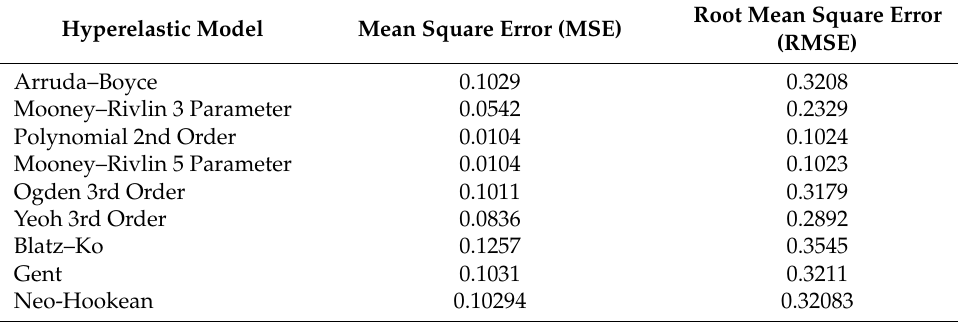
Table 4. RMSE and MSE for the different hyperelastic